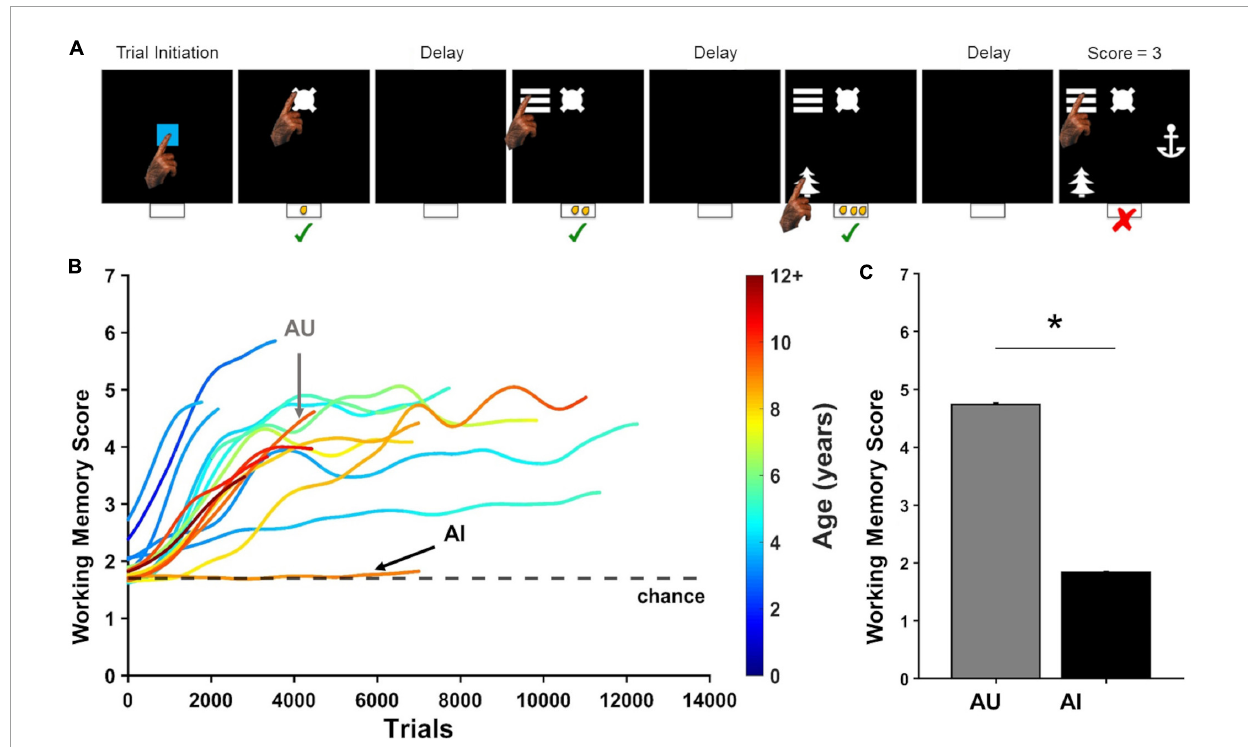
FIGURE1 The delayed recognition span task (DRST) measures working memory. (A) Depiction of one DRST trial. Green checks indicate correct responses. Red X indicates an error. (B) Previously published learning curves for each of the 16 marmosets trained to perform the DRST adapted from Glavis-Bloom et al. (2022). Chance performance is indicated by the black dashed line. Colors of learning curves indicate the age of the marmoset, with color changing within each curve as the animal aged over the course of the experiment. Working memory score is calculated as the average number of correct responses per trial. (C) Average working memory score calculated over the last 500 DRST trials completed for each of two marmosets that performed differently on the DRST (mean ± SEM). * p <